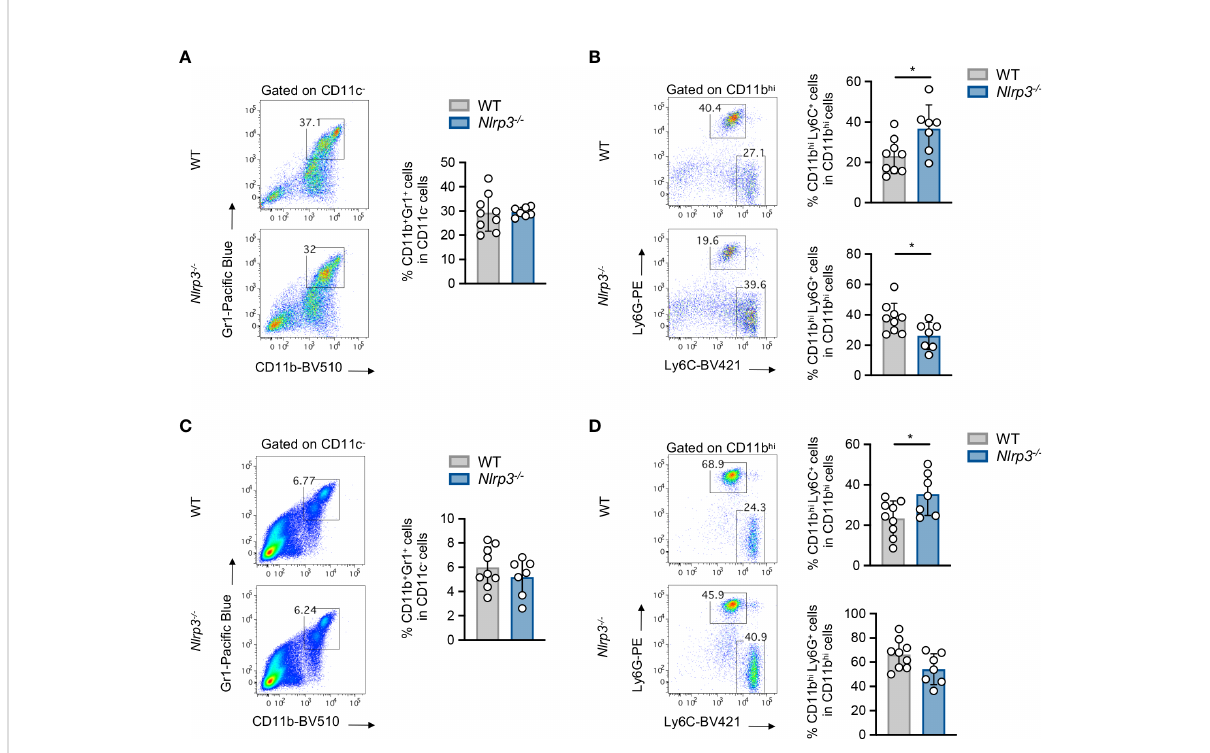
FIGURE 3 Nlrp3 de fi ciency re-arranges the MDSC compartment. (A, B) Representative FACS plots and frequencies of intratumoral MDSC population (A) and MDSC subpopulations (B) , M-MDSCs and G-MDSCs, of WT ( n = 9) and Nlrp3 -/- ( n = 7) mice 15 days after B16.F10 inoculation. (C, D) Representative FACS plots and frequencies of spleen-in fi ltrating MDSC population (C) and MDSC subpopulations (D) , M-MDSCs and G-MDSCs, of WT ( n = 9) and Nlrp3 -/- ( n = 7) mice on day 15 after B16.F10 inoculation. Data are shown as mean ( ± S.D.). Representative data from four independent experiments are shown. Statistical signi fi cance was obtained by unpaired Student ’ s t -test. Symbols: (*), p ≤ 0.05, n = biologically independent mouse